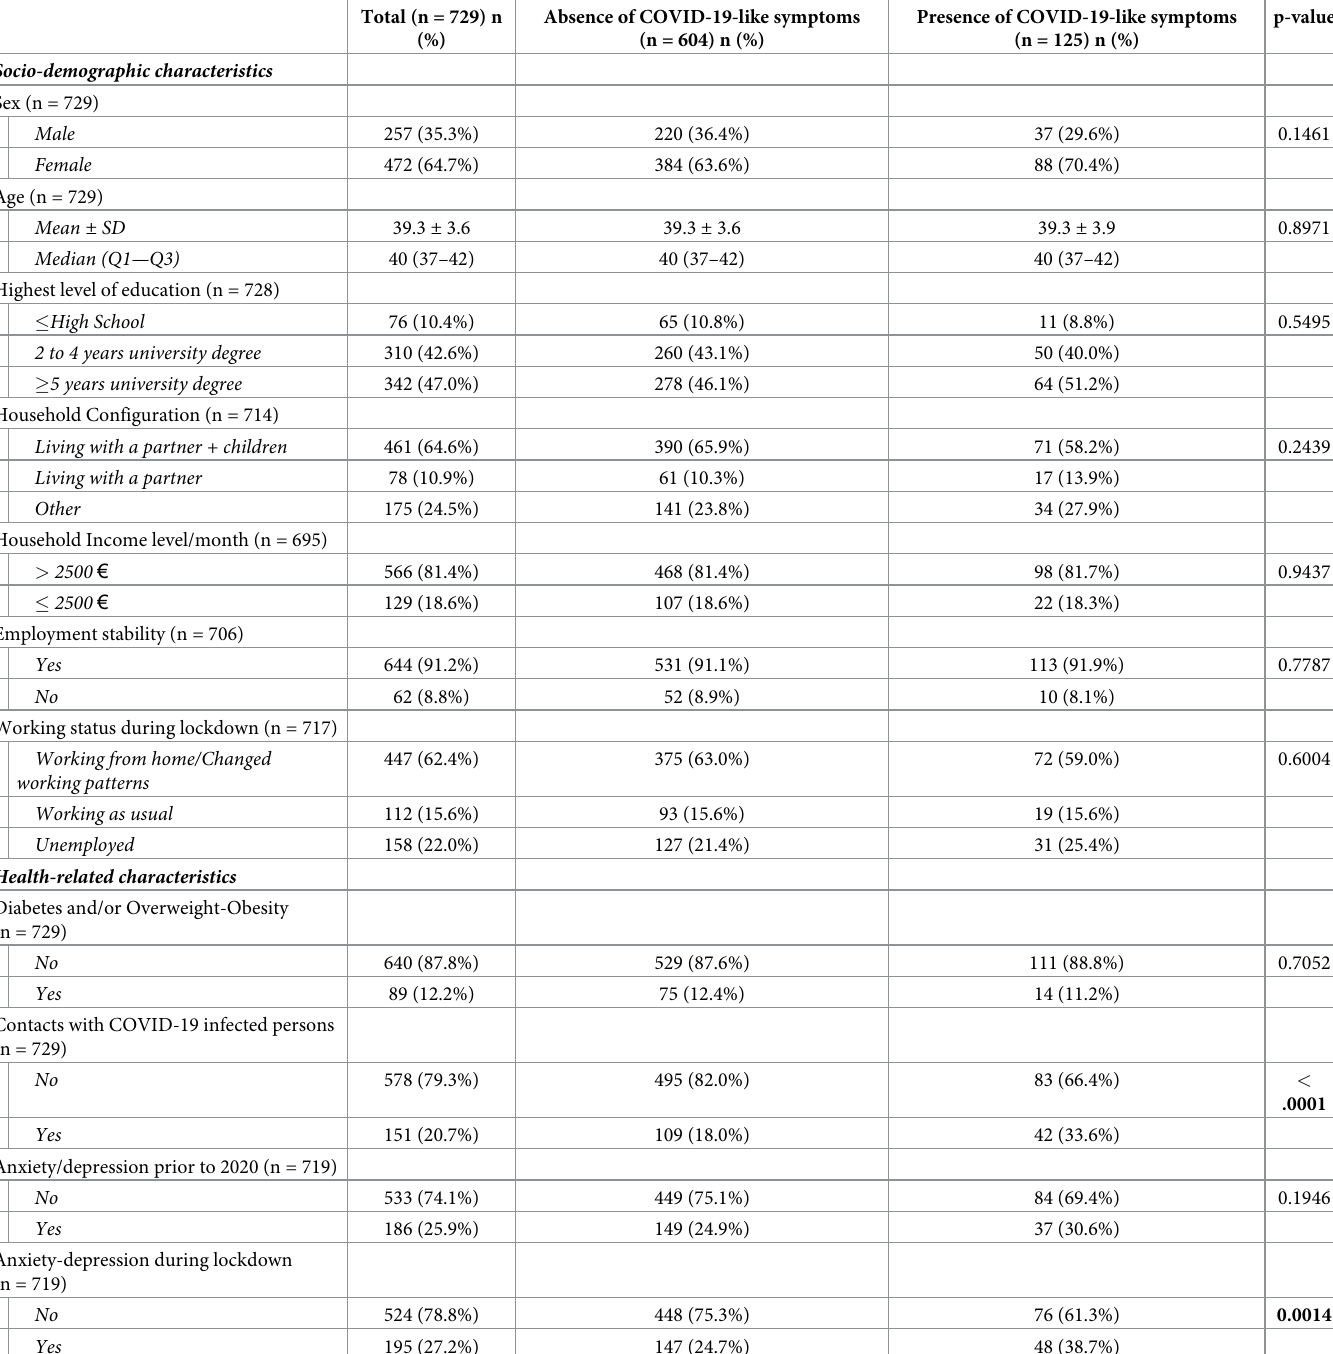
Table 1. Characteristics of TEMPO cohort participants during the first COVID-19-related lockdown (March-June 2020, France, % or mean ± Standard Deviation (SD)).